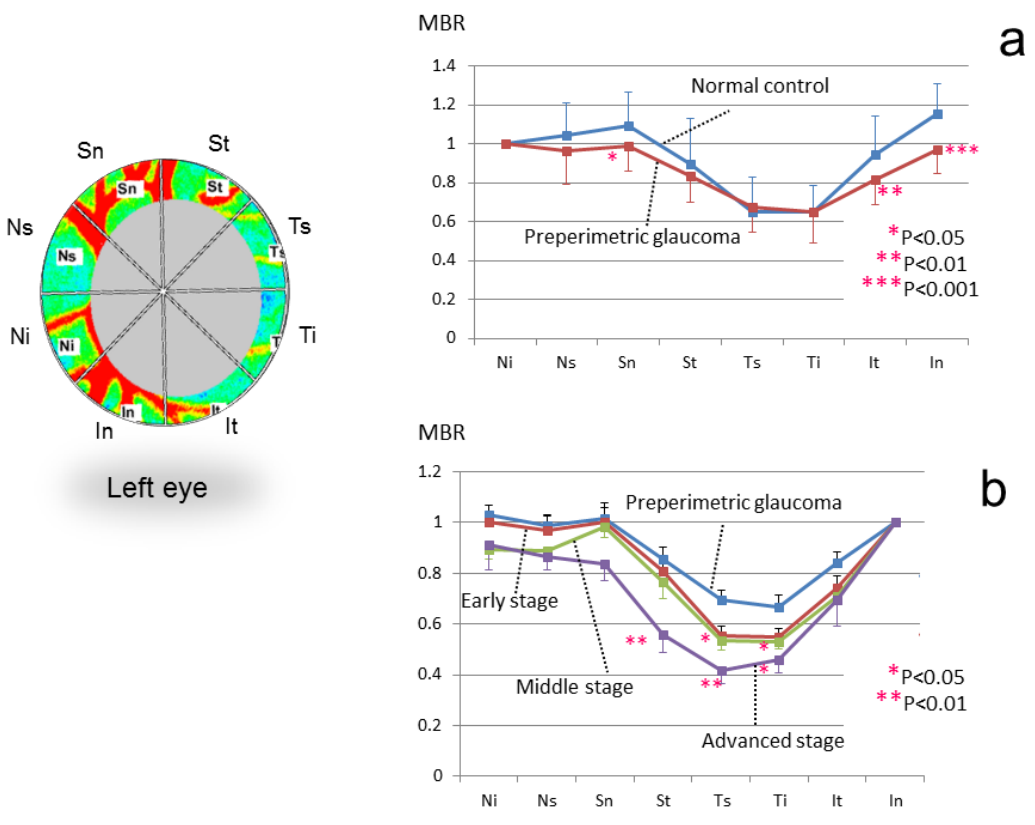
Figure 8. Sectorial analysis of the ONH rim blood flow in patients within each stage of glaucoma. Comparisons between preperimetric glaucoma and normal control ( a ); within each stage of glaucoma ( b